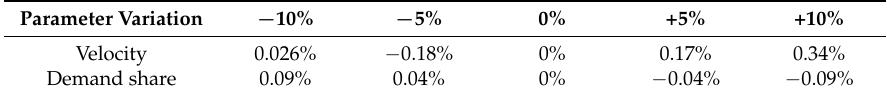
Table 3. Variation of objective induced by parameter variations for a maximum supply temperature increase of 30